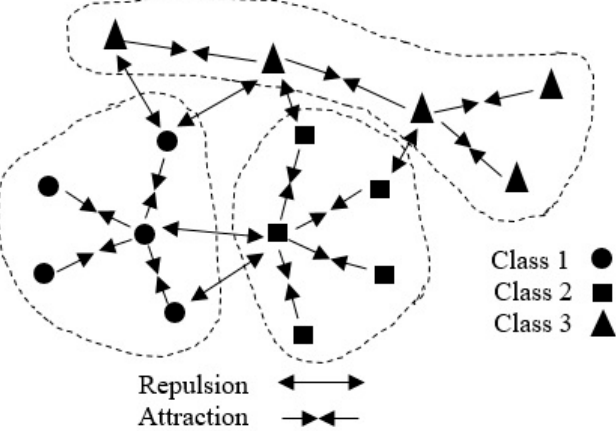
Figure 1. The interactions by attraction and repulsion for the points between different classes.